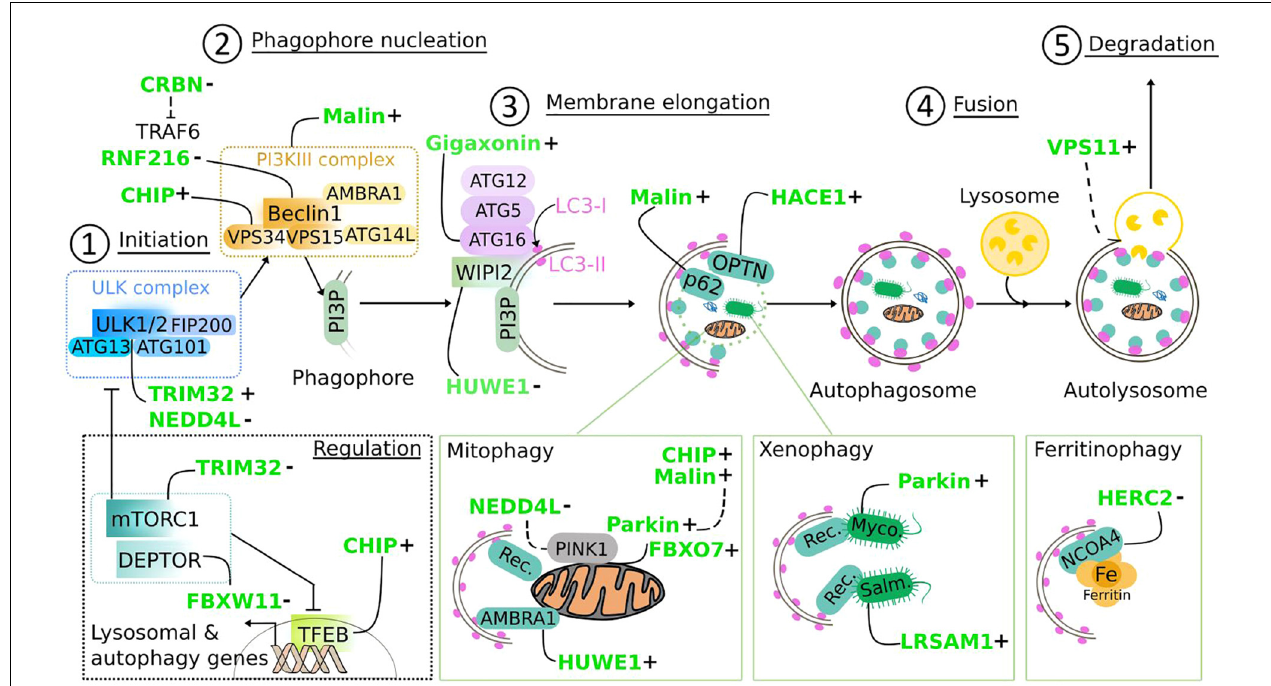
FIGURE 9 | Regulation of the autophagy pathway by E3 ubiquitin ligases. E3 ligases mutated in neurodegenerative diseases (in green) target core components of the autophagy machinery, from the initiation (1) to the fusion of the autophagosome to lysosomes (4) to positively (+) or negatively ( − ) regulate autophagic flux. Following (macro)autophagy induction, the inhibitory effect of mTORC1 on the ULK complex is lifted, allowing the activation of the ULK1/2 kinases (1) , leading to a cascade of phosphorylation events that contribute to the activation of the PI3KIII complex via Beclin1, to promote PI3P synthesis on nascent phagophore (2) . Interacting with PI3P, WIPI2 subsequently recruits ATG16L1 in complex with ATG12-ATG5, the E3 ligase that catalyzes the lipidation of LC3 at membranes, a step (3) required for membrane elongation and autophagosome formation. Fusion with lysosome (4) leads to the degradation of sequestered material, which can be non-specific (called bulk autophagy) or specific (called selective autophagy). Selectivity is triggered by ubiquitination of substrates [ (bottom panels) mitochondria, pathogens, and Ferritin], and mediated by adaptor proteins that direct them to autophagosomes thanks to LC3-interacting region (LIR domain) and ubiquitin-associated domain (UBA) domain. “Rec” for mitophagy: p62, OPTN, NDP52, TAX1BP1, NBR1, or AMBRA1; of note, some mitochondrial proteins have a LIR domain and contribute to mitophagy. “Rec” for xenophagy: p62, NDP52, NBR1. Myco., Mycobacterium tuberculosis; Salm., Salmonella Thyphimurium. mTOR signaling, which is an upstream inhibitor of autophagy induction is also regulated by E3 ligases: through action on mTOR inhibitors (DEPTOR) and transcriptional control of autophagy genes (TFEB). Dashed line: partial demonstration of mechanistic. E3 ligase-dependent ubiquitination can trigger degradative or non-degradative routes. Several E3 ligases act at multiple steps of the autophagy pathway and can have antagonized actions.